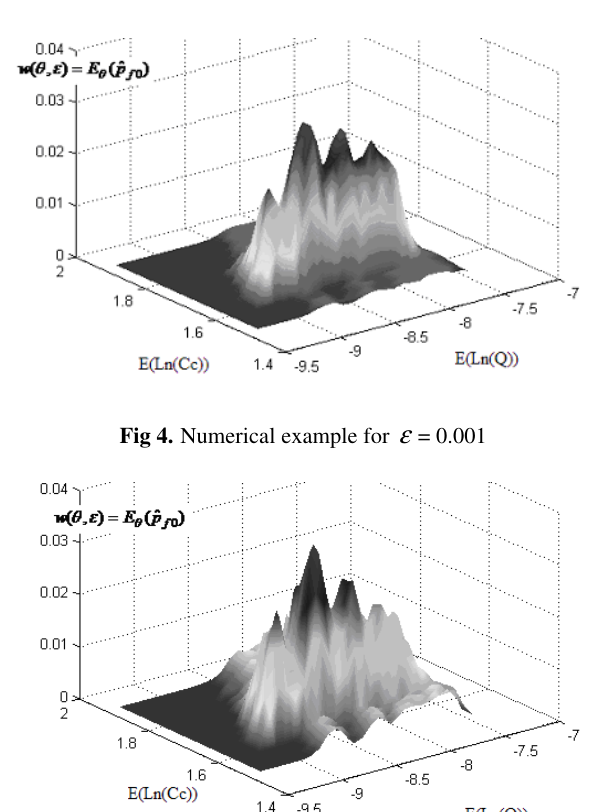
Fig 3. Example of FCGMP estimates and of some set of fatigue cracks under equal stress level